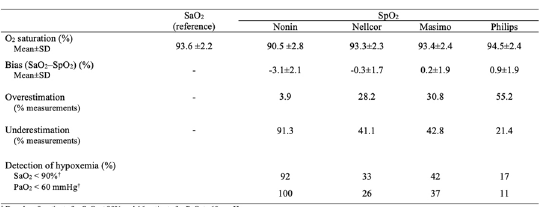
Table 1. Main features of evaluated oximeters. Mean, standard deviation, percentage of over and underestimation of the SaO 2 and detection of hypoxemia for tested